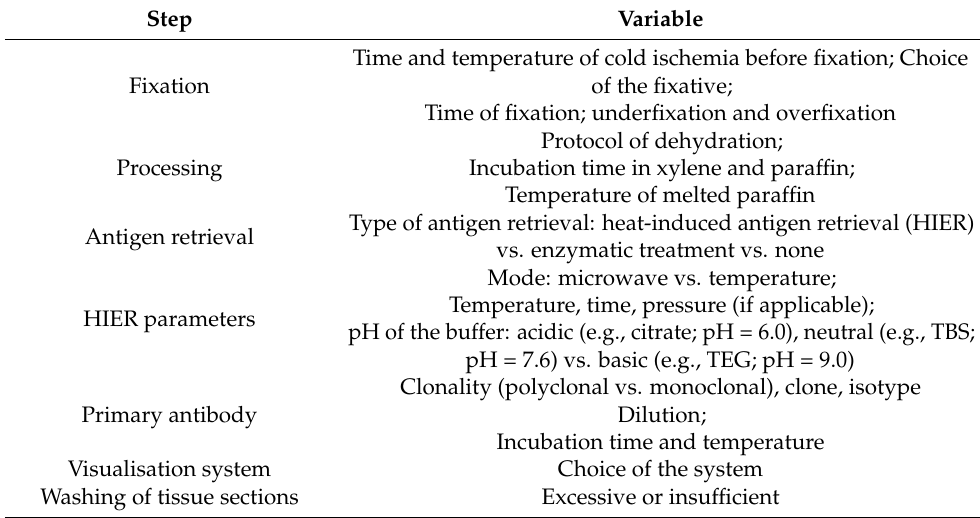
Table 4. Technological variables influencing immunohistochemical